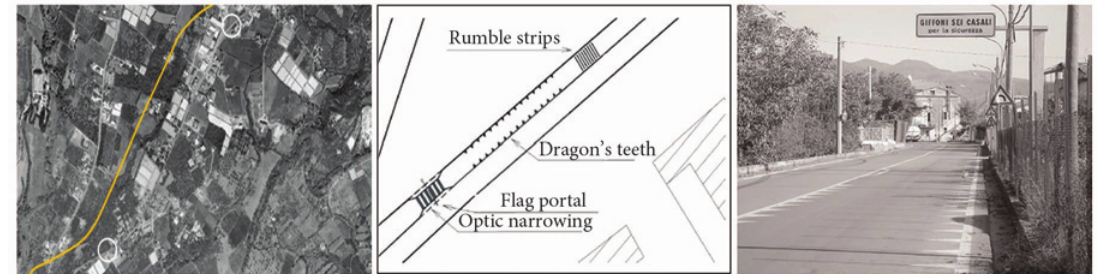
Fig. 3. Traffic calming design in the dangerous crash scenario (Dell’Acqua 2011)